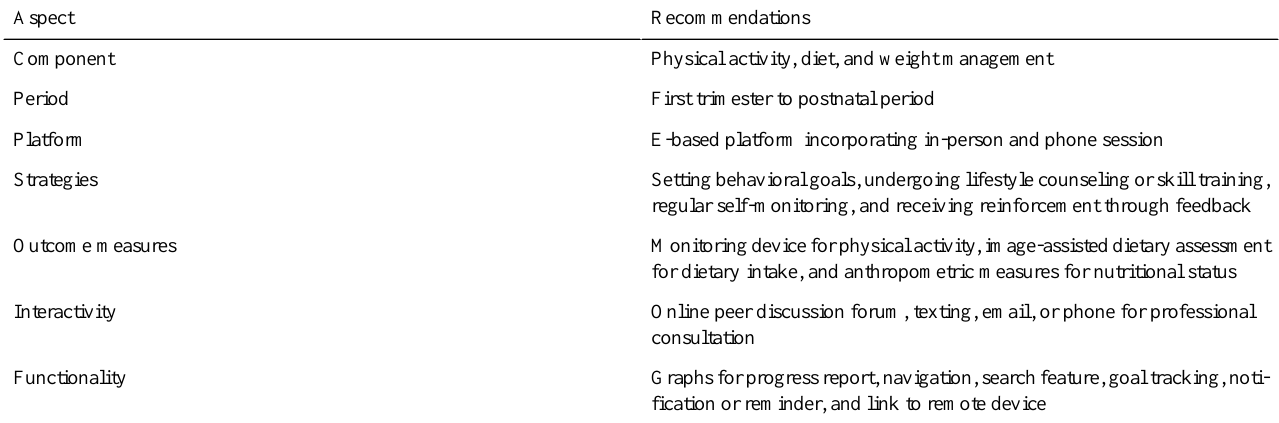
Table 1. Recommendations from the systematic review and meta-analysis. RecommendationsAspect